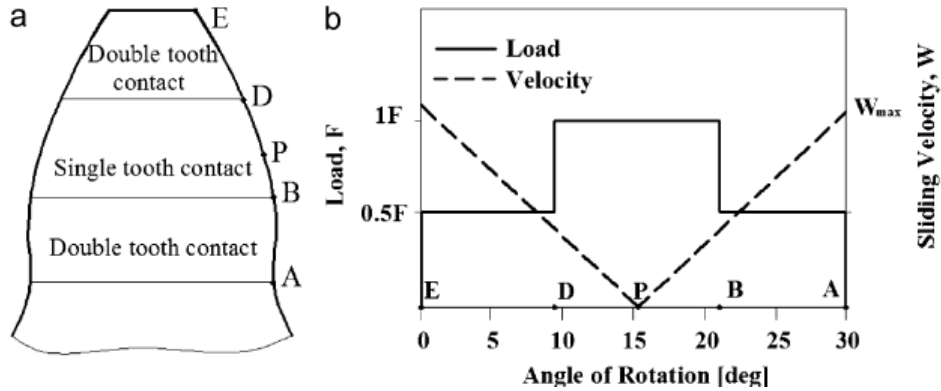
Figure 1. ( a ) Tooth contact areas and limits ( b ) load-surface velocity distribution